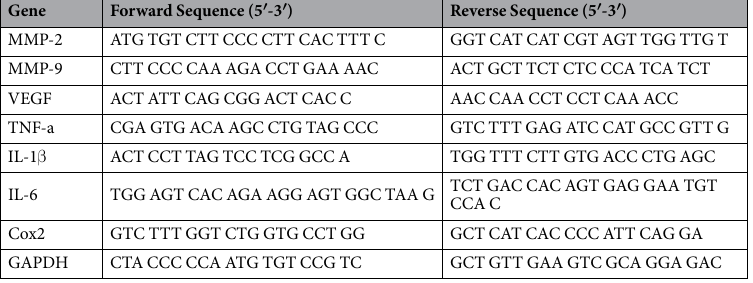
Table 1. Primers for real time